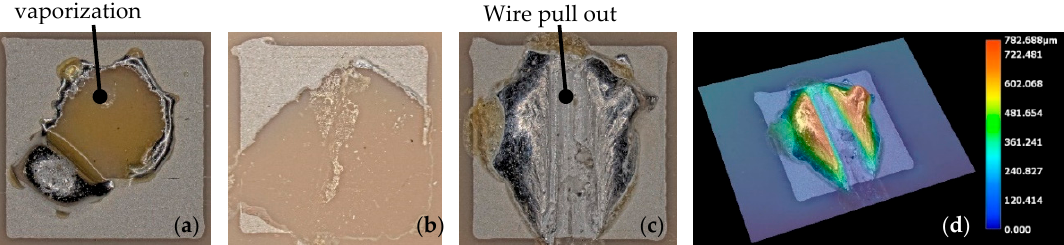
Figure 4. Failure modes of wire bond pull samples. ( a ) Printed ink vaporization, ( b ) adhesive failure of conductive ink, ( c ) wire pull out, ( d ) wire pull out colormap.